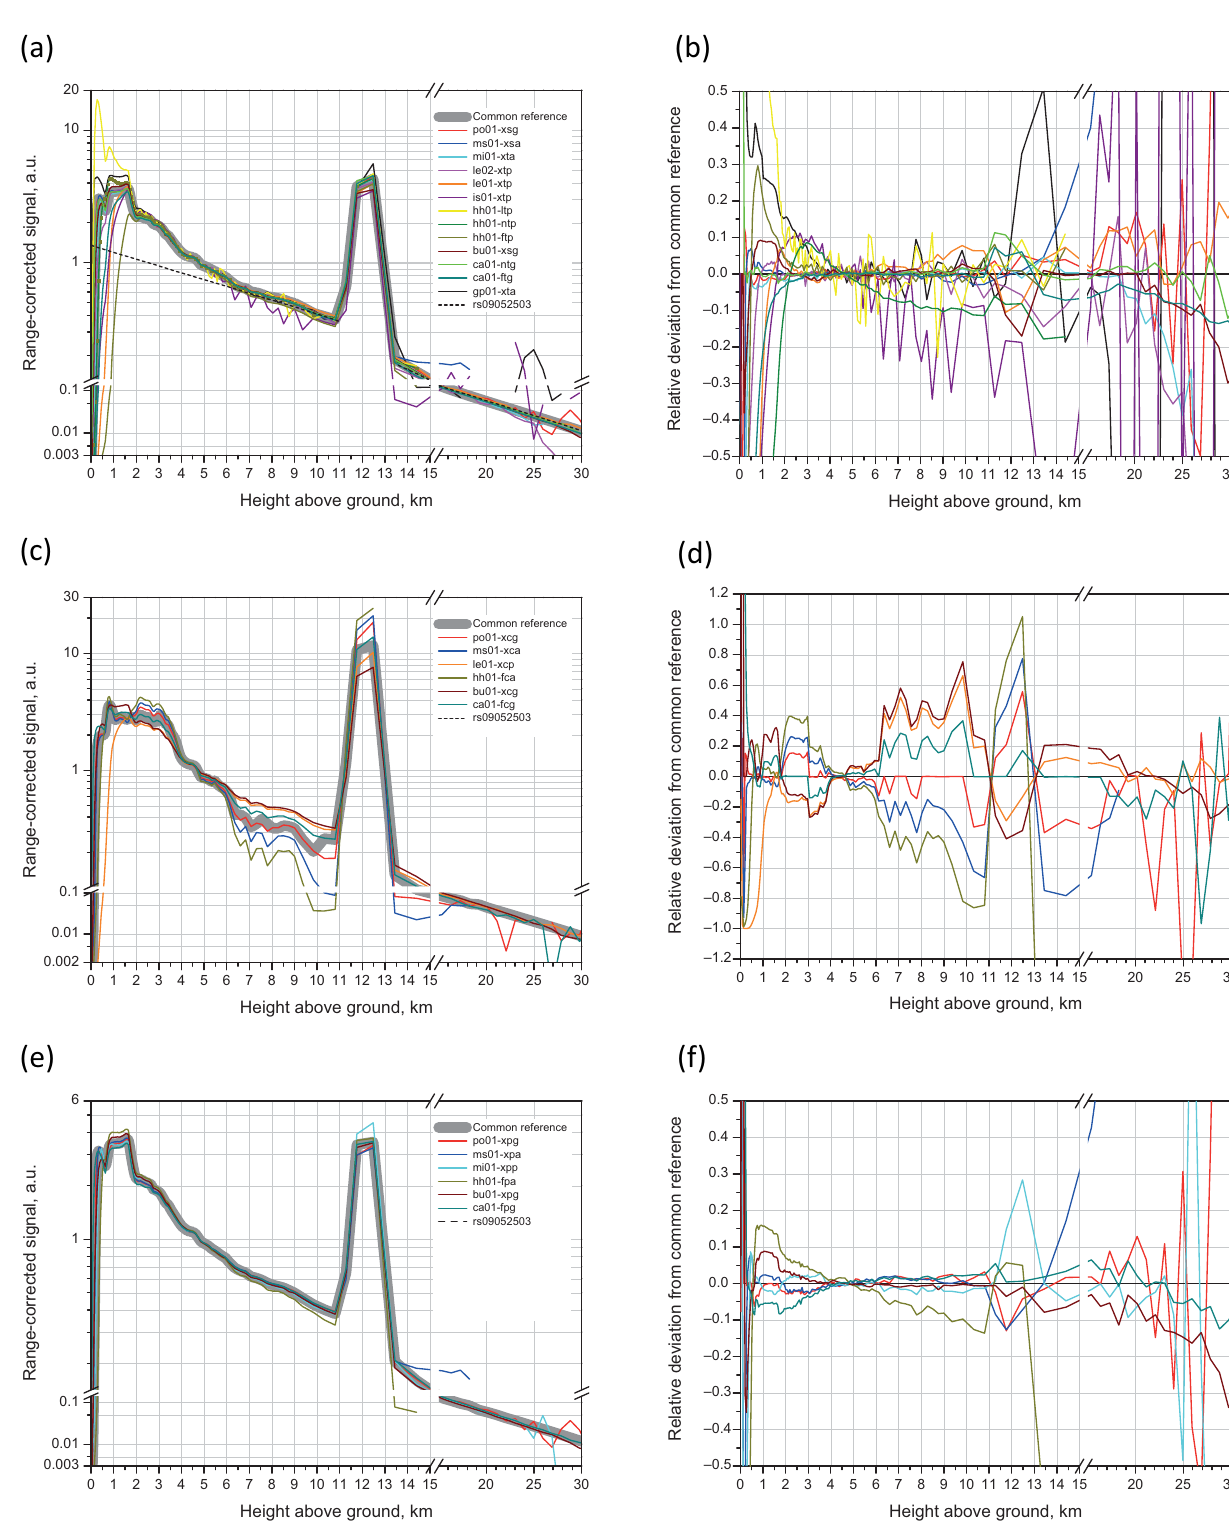
Figure 4. Same as Fig. 3, but for (a, b) total, (c, d) cross-polarized, and (e, f) parallel-polarized signals at